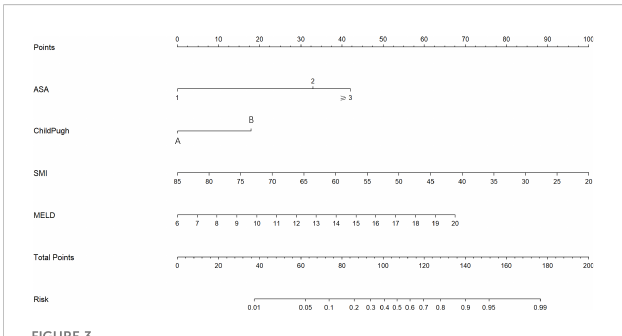
FIGURE 3 The nomogram for the prediction of PHLF. The nomogram was established based on the training cohort. PHLF, post-hepatectomy liver failure.